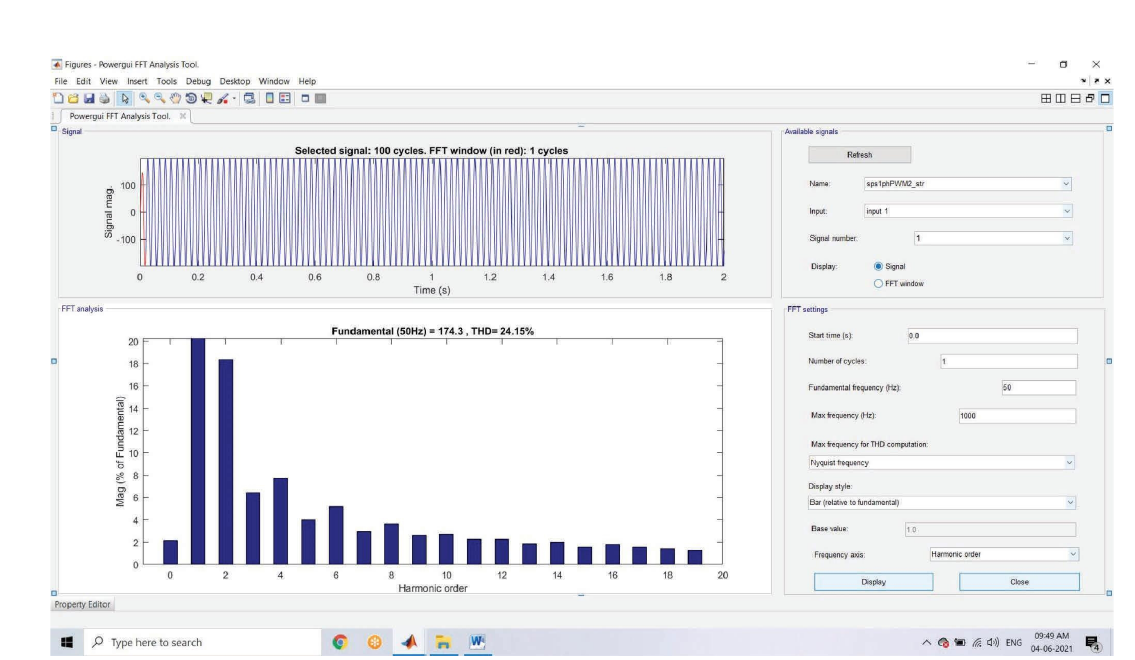
Figure 14: Total harmonic